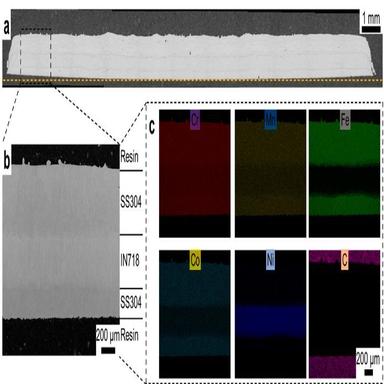
Large MMS sample (Case-4) printed with the island scanning strategy: (a) overview of the middle cross-section and (b) zone magnification and (c) the corresponding EDX maps for different chemical compositions.